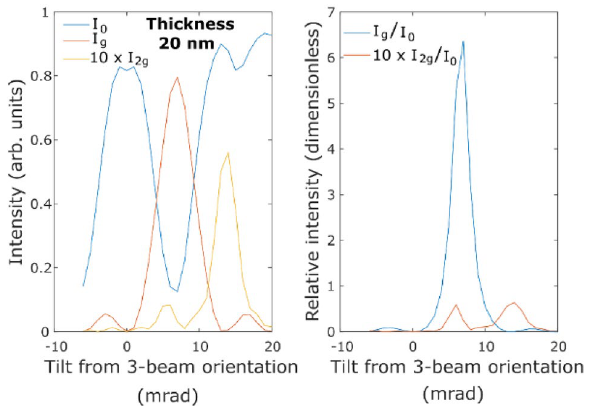
Figure 2. Intensities of transmitted beam and Bragg-scattered beams g and 2g and their ratios as a function of beam tilt for a 20 nm thick sample of bcc